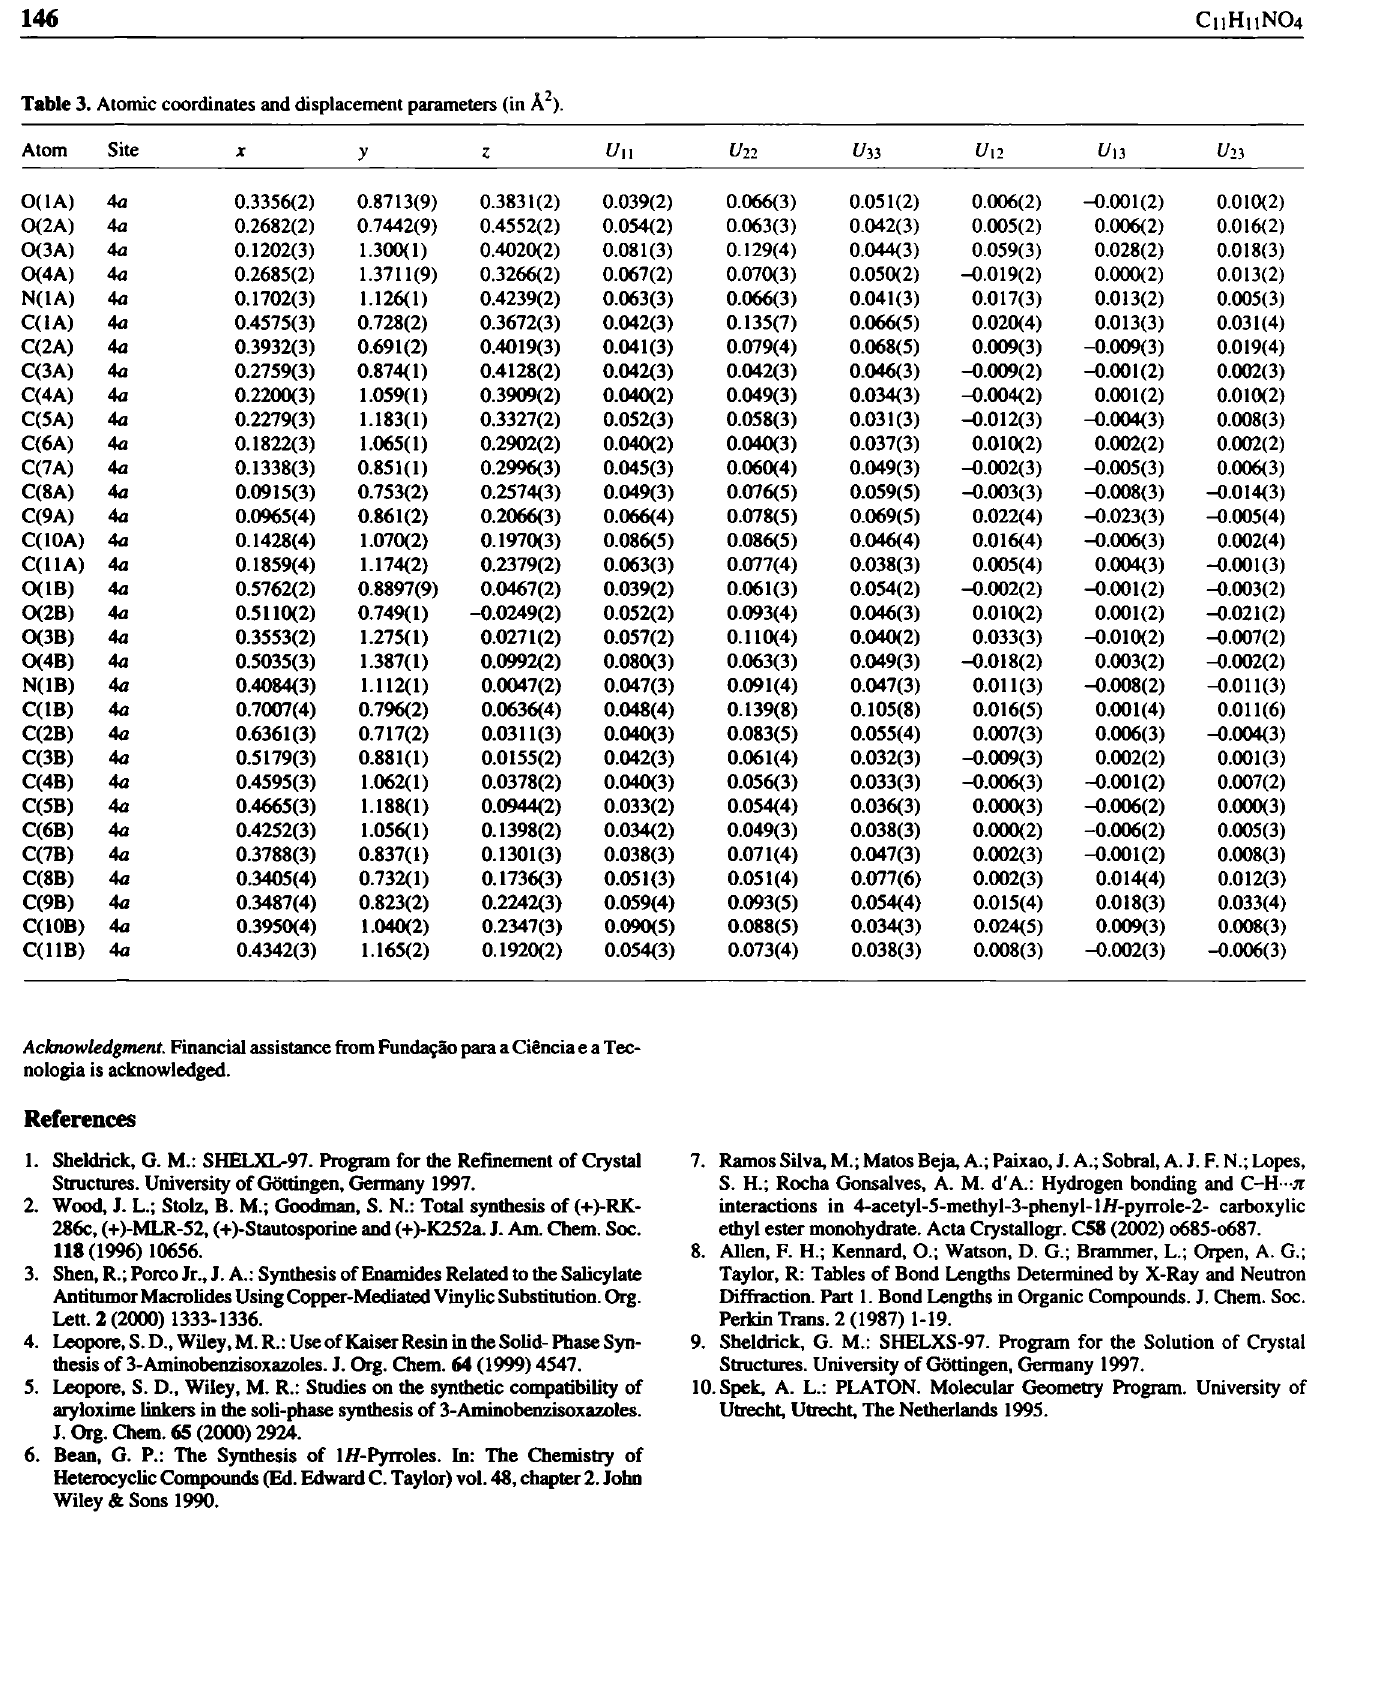
Table 3. Atomic coordinates and displacement parameters (in À 2